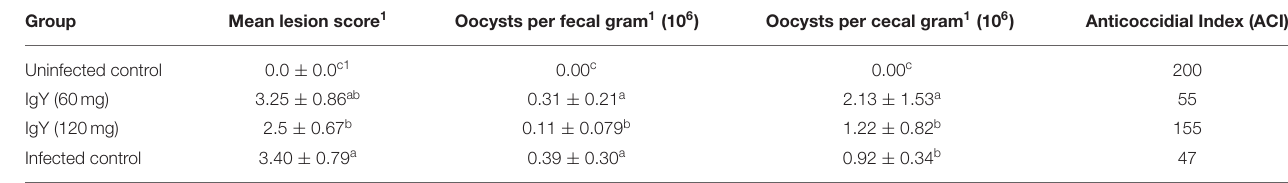
TABLE 3 | Immunotherapy protection by the Eimeria sp.-specific IgYs against a severe E. tenella infection in SPF White Leghorn chickens. Group